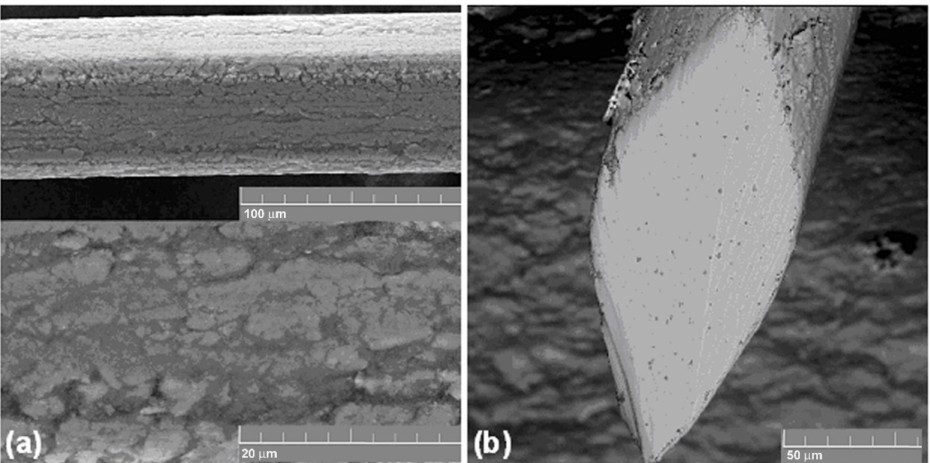
Figure 9. Superelastic 60 µ m diameter NiTi wire: ( a ) side view; ( b ) cross-section. For comparison with the stress-strain curves of mesh knitted from NiTi wire, 60 µ m diameter NiTi wire was tested. The obtained engineering stress-strain curves of the NiTi wire corresponded to typical stress-strain curves of nitinol wire (Figure 10).